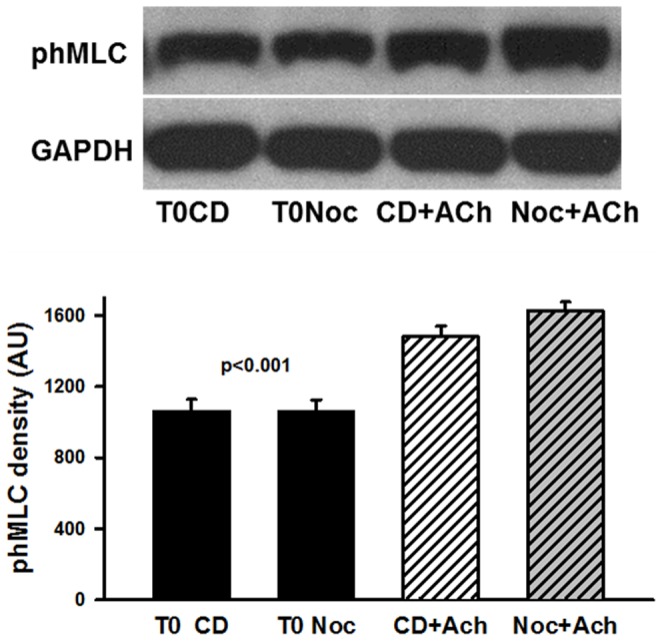
MLC activation during Ach challenge and dynamic loading in the presence of CD or Noc.phMLC is significantly increased by the end of 90: time 0 before stretch, CD+Ach and Noc+Ach correspond to phMLC at the end of 90 min stretch in the presence of CD or Noc, respectively. GAPDH (∼35 KDa) is loading control. Data are presented in arbitrary units (AU). Statistical significance is given for the comparisons between T0 CD and CD+Ach and between T0 Noc and Noc+Ach.